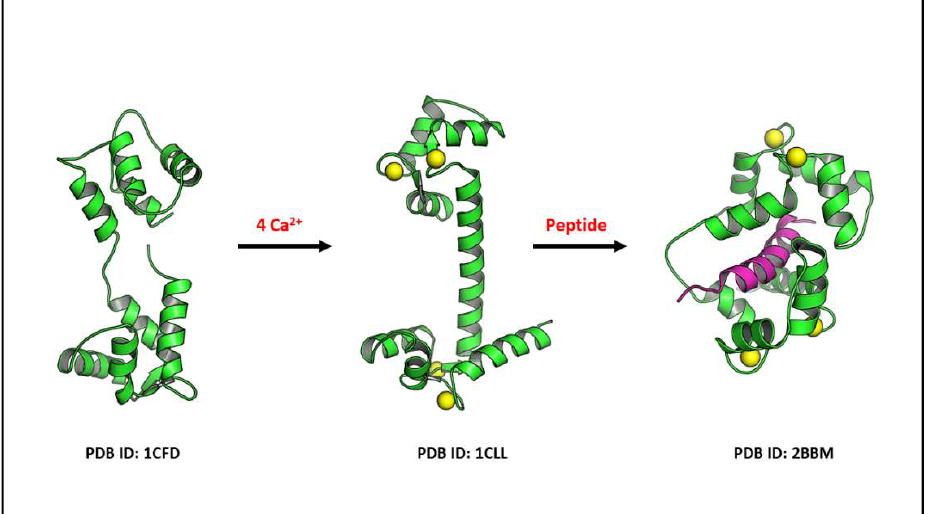
Figure 2. The 3D illustrations show the flexibility of calmodulin in binding to 4 Ca 2+ and undergoing conformational changes for its reaction with a specific downstream protein, such as the CaM kinase proteins. Specifically, the binding of the calcium–calmodulin complex to auto-inhibitory target protein regions leads this conformational change and the target protein activation. Ca 2+ is displayed as yellow balls and peptide is shown as magenta ribbon.